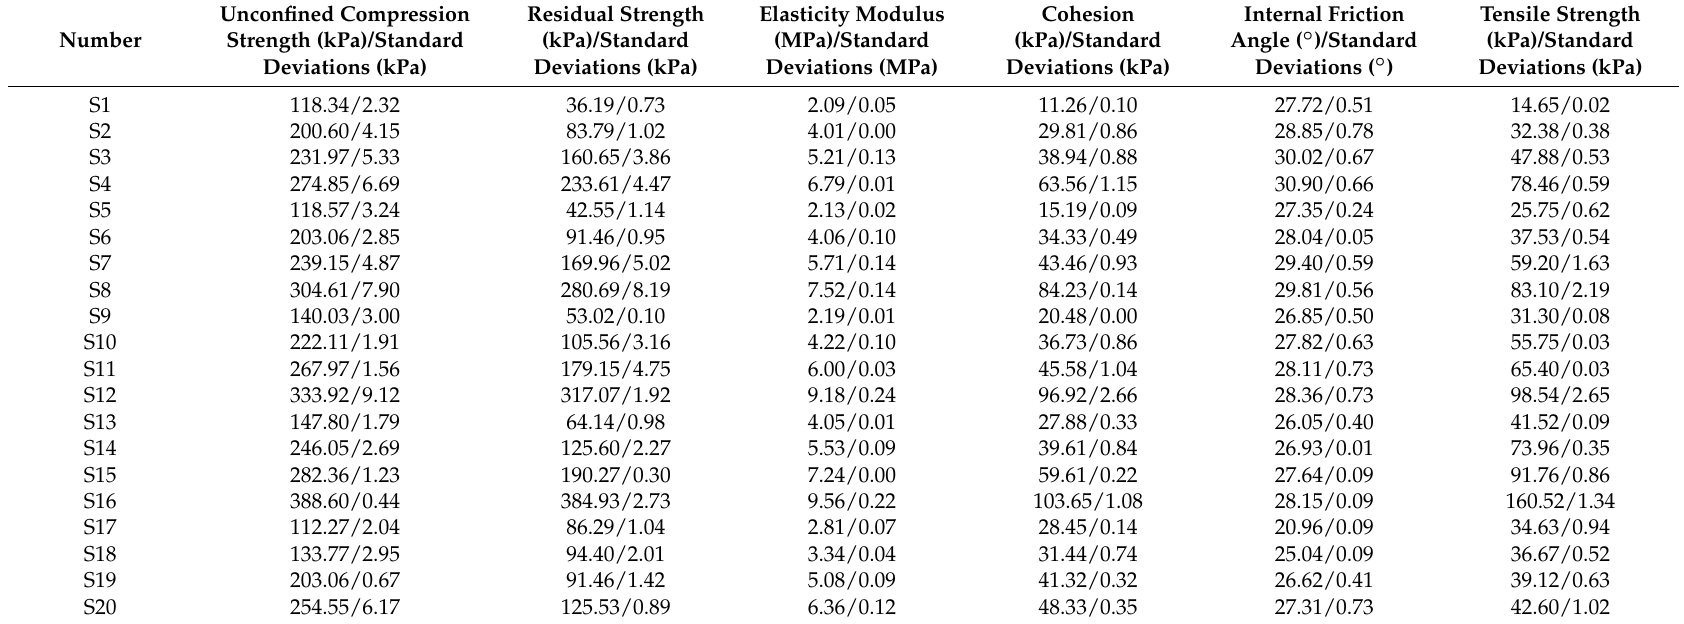
Table 4. The results of the strength